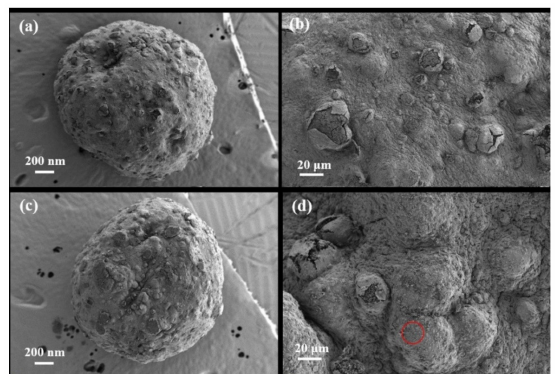
Figure 1. Morphological characterizations of CA-Al-KABs (aluminum-pillared kaolin sodium alginate beads) (( a ) and ( b )) and Post-CA-Al-KABs (( c ) and ( d